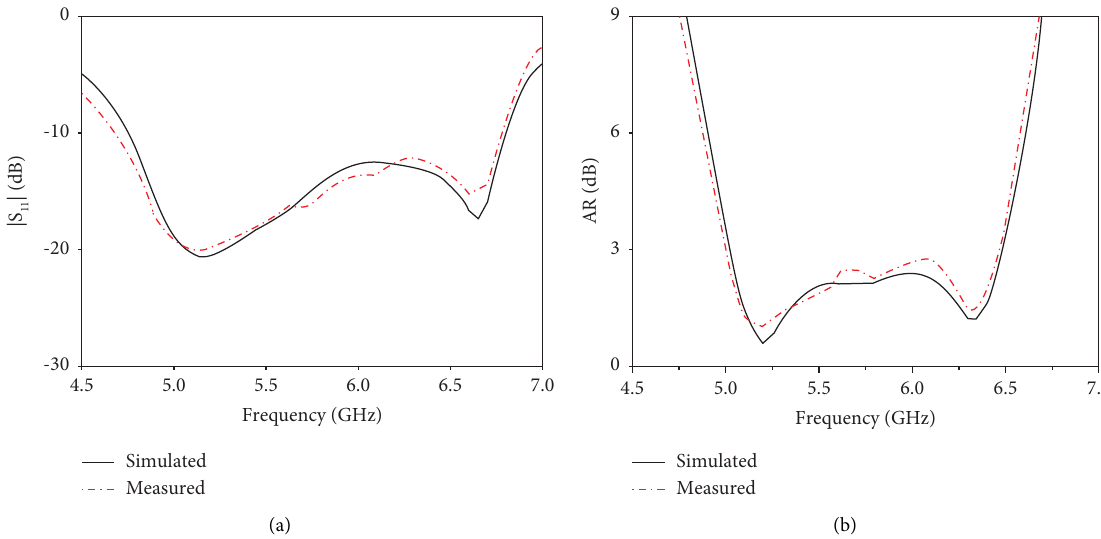
Figure 6: Simulated and measured results with frequencies change. (a) | S